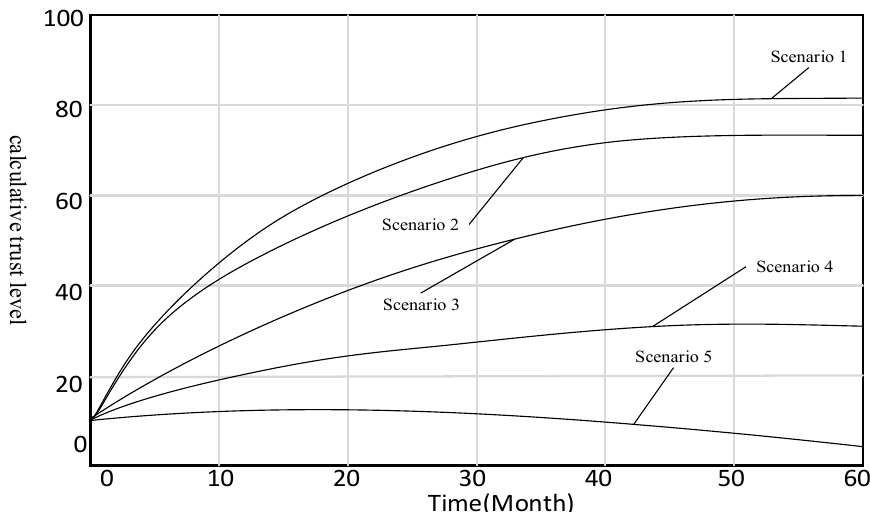
Figure 4. An example of a model validity test.